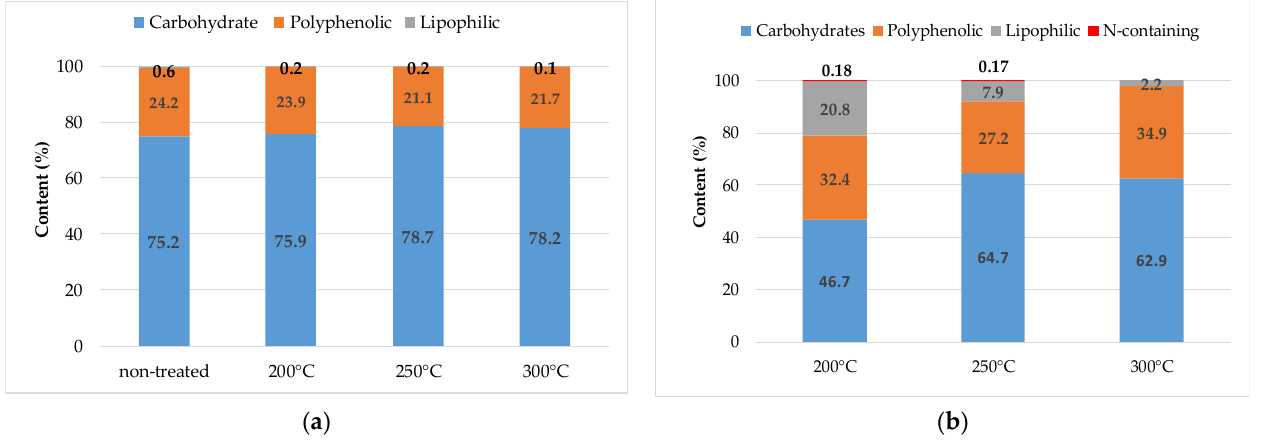
Figure 5. The relative content of carbohydrate, polyphenolic, lipophilic, and N-containing constituent-derived products in pyrolysis volatiles of the non-treated and torrefied softwood solid fractions ( a ) and in tar fractions ( b ), depending on the MW treatment temperature.